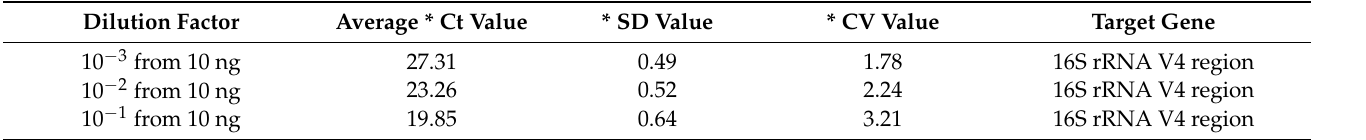
Table 2. Average standard curve calculation results using qRT-PCR assay.